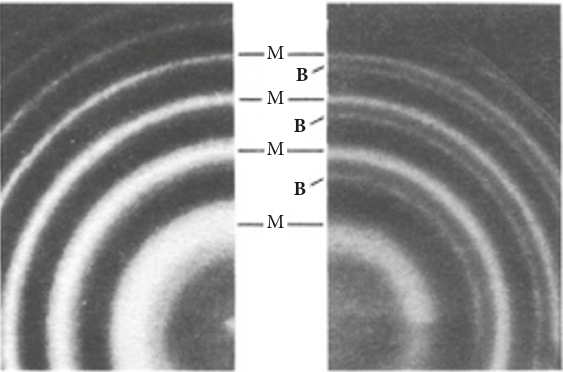
Figure 1: Fabry-Perot interferograms of Q-switched ruby laser radiation (rings labeled M) and of the Brillouin scattered Stokes radiation (rings labeled B). Left shows laser alone, right is observa- tion with the laser focused into quartz [adapted from